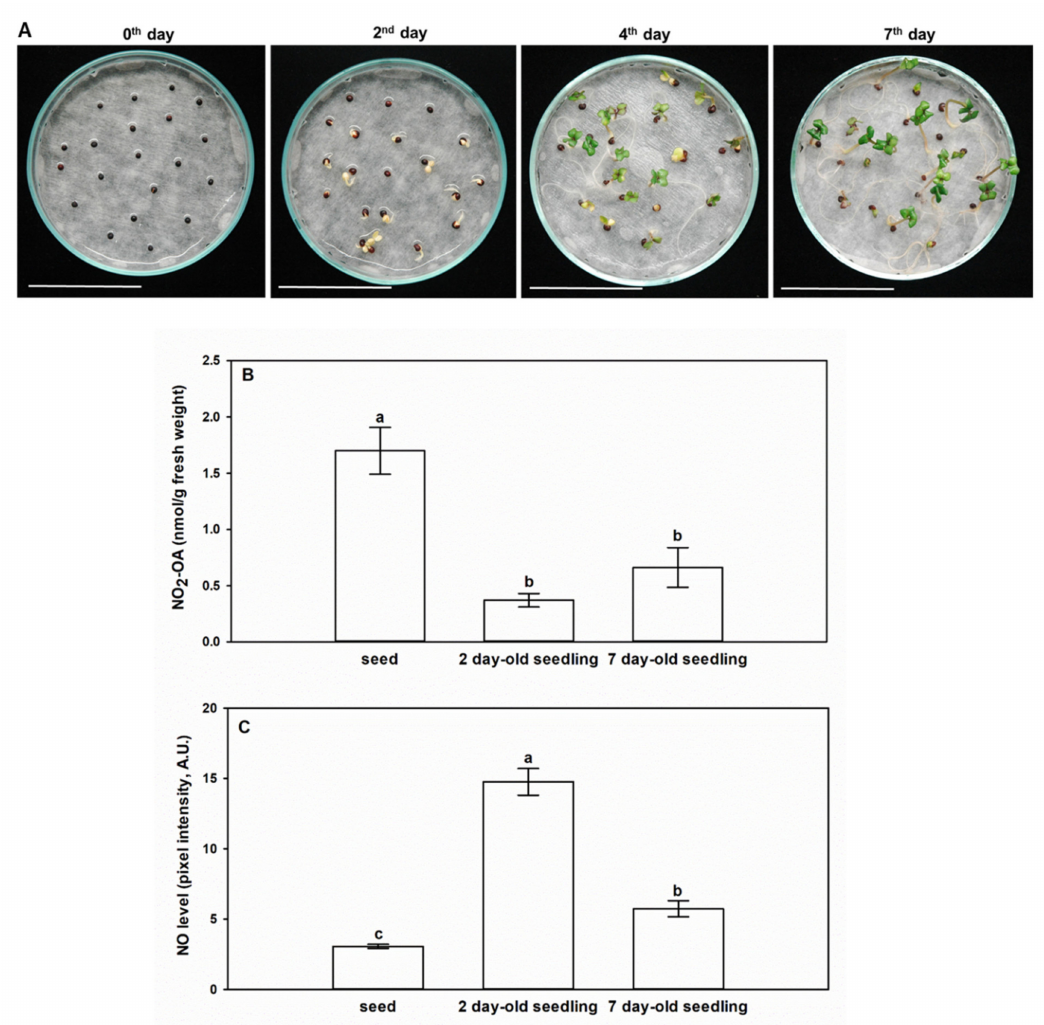
Figure 3. Levels of NO 2 -OA and • NO change in opposite ways in the early stage of germination (day 0) and during seedling growth (2nd, 4th and 7th days). ( A ) Representative photographs taken from Brassica napus seedlings on day 0, and 2nd, 4th, and 7th day after sowing. Bars = 4.5 cm. ( B ) Mean concentrations of NO 2 -OA (nmol / g fresh weight, with standard errors) in seeds and di ff erently developed seedlings of Brassica napus . ( C ) • NO levels (pixel intensity, arbitrary unit) in Brassica napus seeds, 2 day-old and 7 day-old seedlings. Di ff erent letters indicate significant di ff erences according to the Holm–Sidak test (P ≤